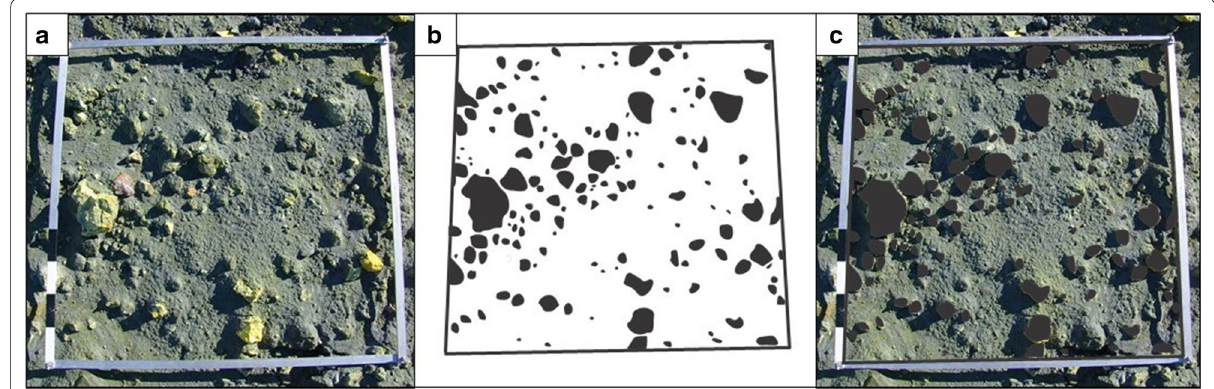
Fig. 4 An example of image analysis from framed images in the field ( a ), processed to binary ( b ) and with the overlay ( c